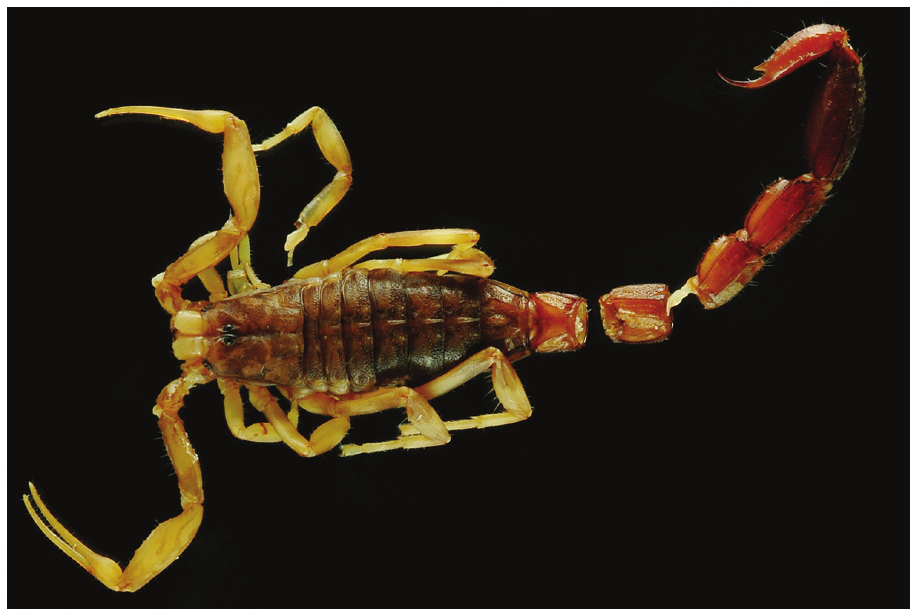
Figure 7. Ananteris sabineae , female holotype from upper Ouarimapan river (photo MNHN / E.-A.